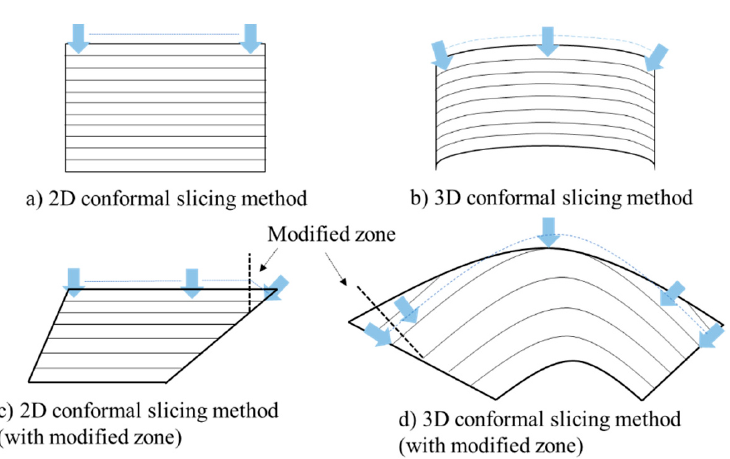
Figure 4. AM volume slicing strategies on a robotic system using adaptive conformal trajectory.